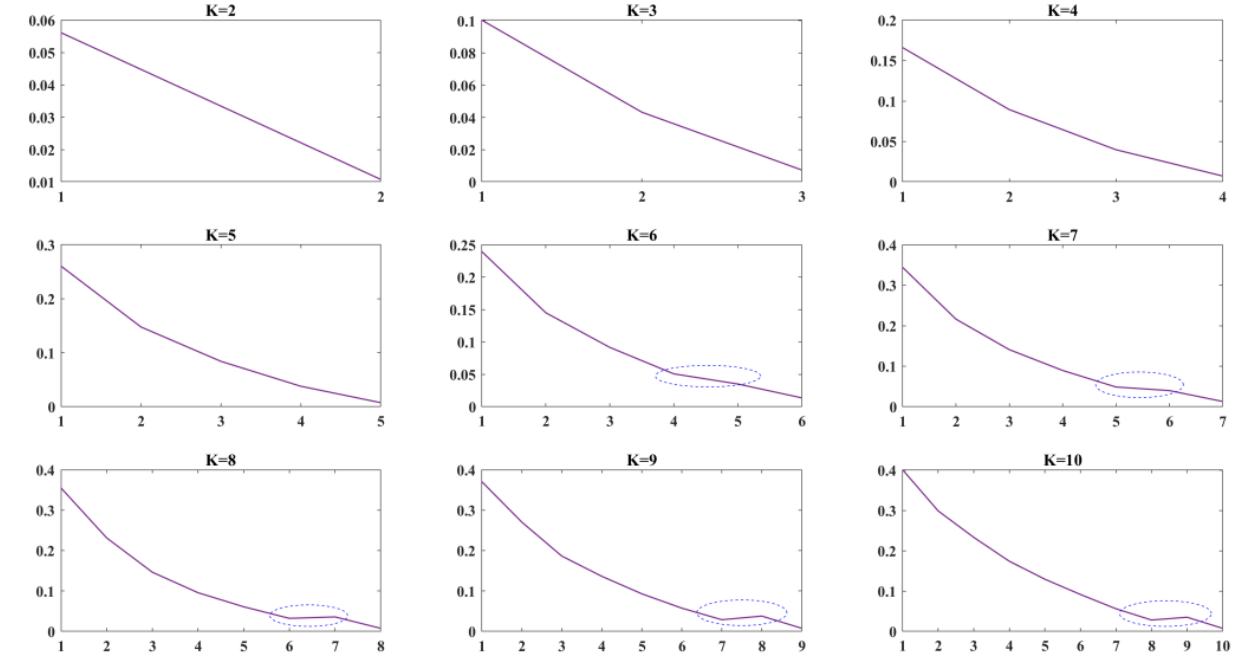
Figure 7. EX5 k value